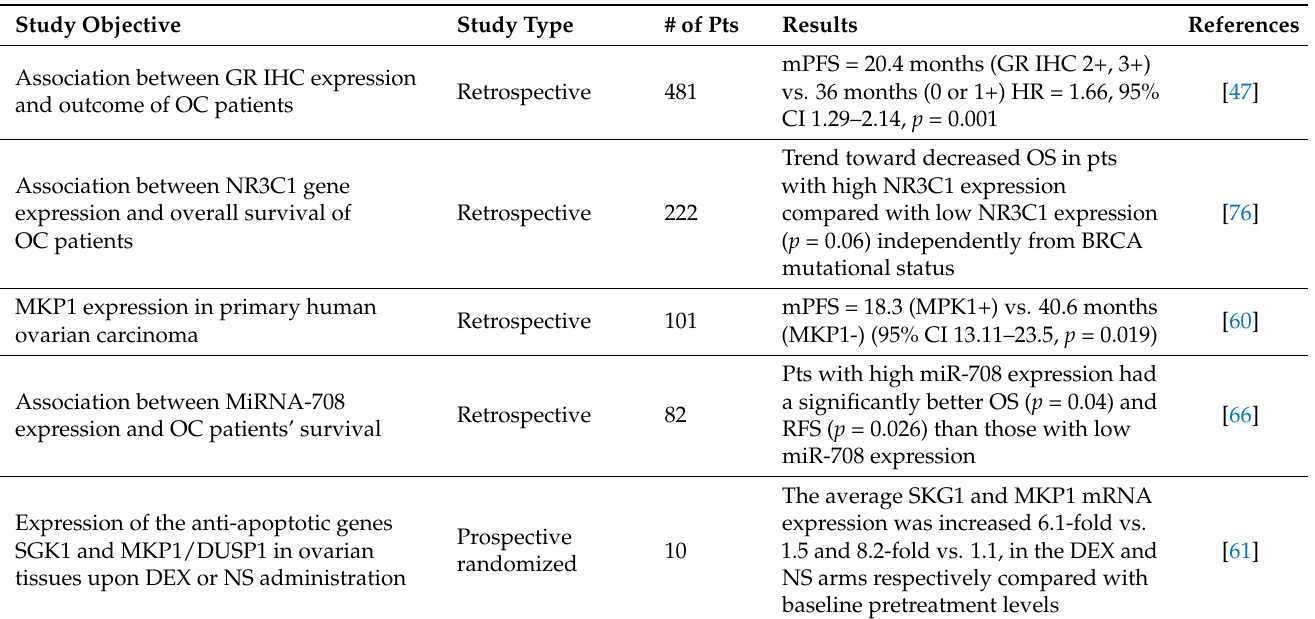
Table 1. Retrospective trials exploring GR